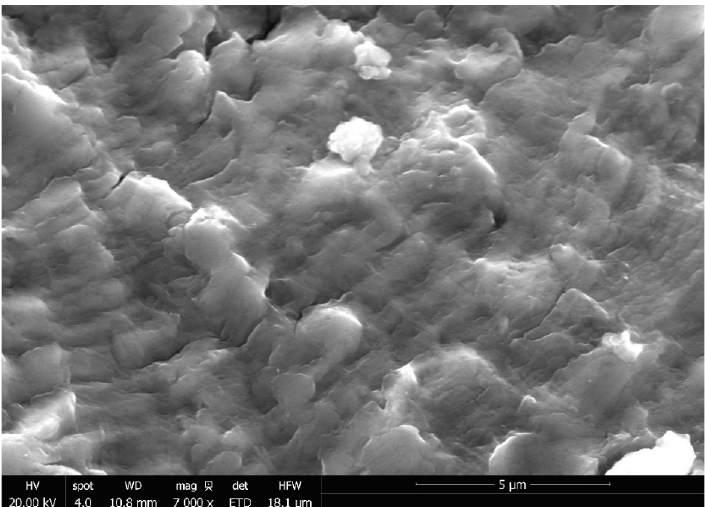
Figure 15. Topographical SEM image of the fracture surface striations.